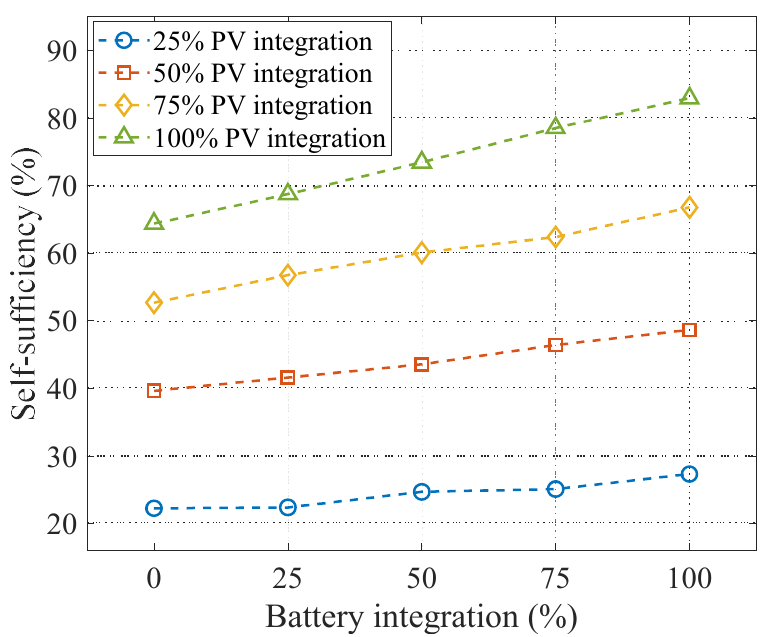
Figure 11. The improved community self-sufficiency with different ratios of PV and battery integra- tion.